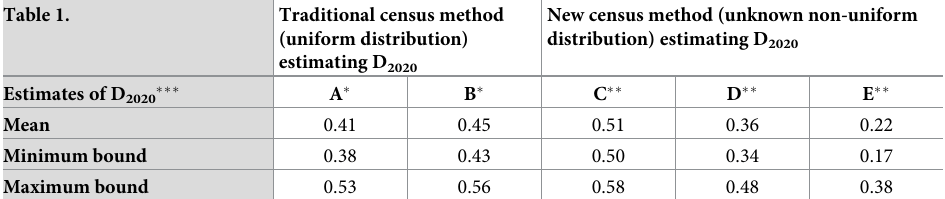
Table 1. Estimates of the annual mortality rate (D 2020 ) of Wisconsin wolves between 15 April 2020 and 14 April 2021. We used two census methods to estimate N 2020 and N 2021 and reproductive parameter R (mean, lower and upper bounds of the 95% CI from [53] for 256 wolf packs. D is estimated as (N 2021 -N 2020 ) divided by (0.5 � R 2020 +